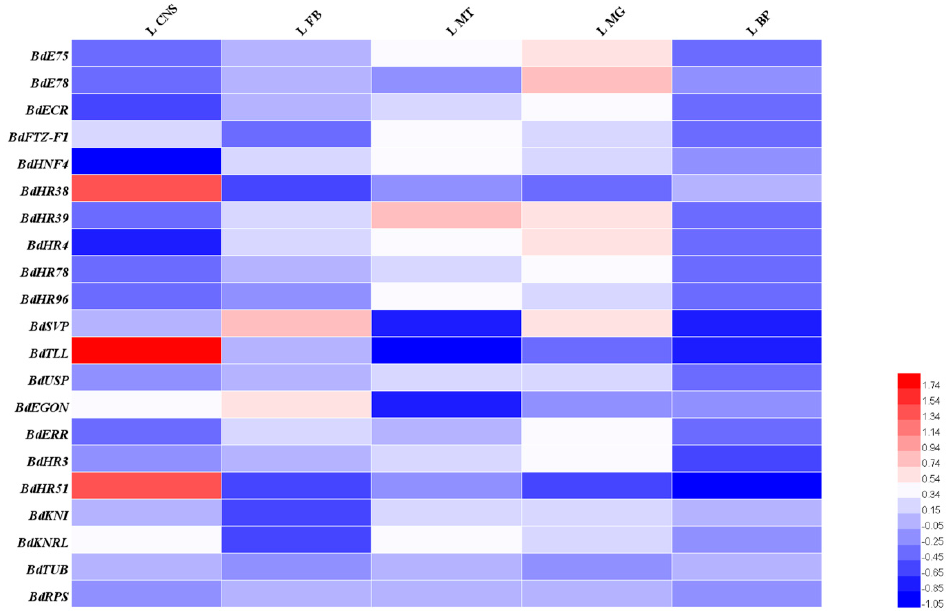
Figure 5. Tissue-specific expression of 19 NR B. dorsalis genes (excluding BdHR83 and BdDSF ) from third instar larvae. Relative transcript levels were calculated using α -tubulin (GenBank Accession no.: GU269902) and rps3 (GenBank Accession no.: XM_011212815) as internal references. Three to four independent biological replicates and two technical replicates were performed for each qRT-PCR. Larval midgut (L MG); larval fat body (L FB); larval cuticle (L BP); larval Malpighian tubule (L MT); larval central nervous system (L CNS). Warm colors (i.e., red) indicate high expression levels and cold colors (i.e., blue) indicate low expression